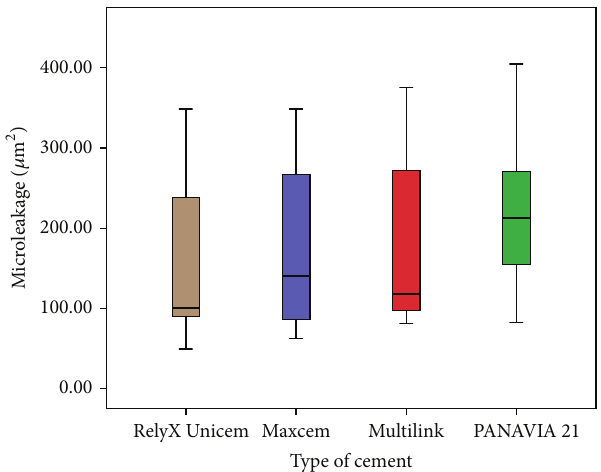
Figure 2: Microleakage areas ( 𝜇 m 2 ) values for each cement group.